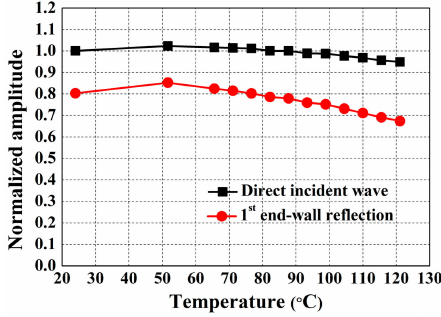
Figure 7. The normalized amplitudes of the direct incident wave and the first end-wall reflection as a function of the